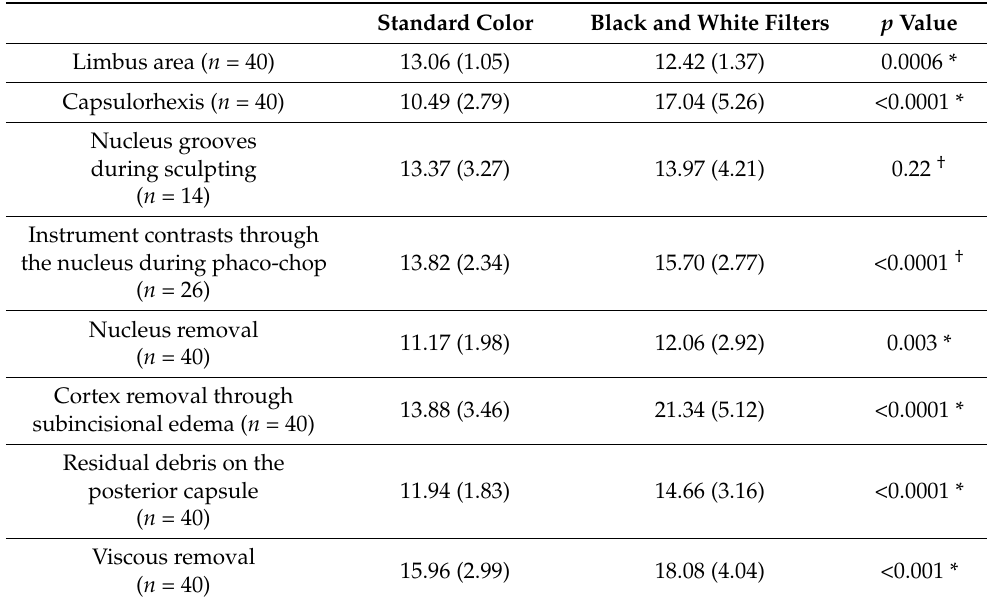
Figure 2. Images obtained during surgery highlighting tissue color modifications with the BW filter. The corresponding natural color images are shown above the black ‐ and ‐ white images. ( a ) Conjunctival vessels tend to disappear with the filter. The red reflex becomes a light, bright ‐ gray reflex. ( b ) Peripheral gerontoxon is less visible with the BW filter. ( c ) The contours of the nucleus were enhanced by the BW filter, but the shades of the colors of the different crystalline layers were attenuated. Table 2. Comparison of contrast (DSD) between color and black and white images during the various steps of cataract